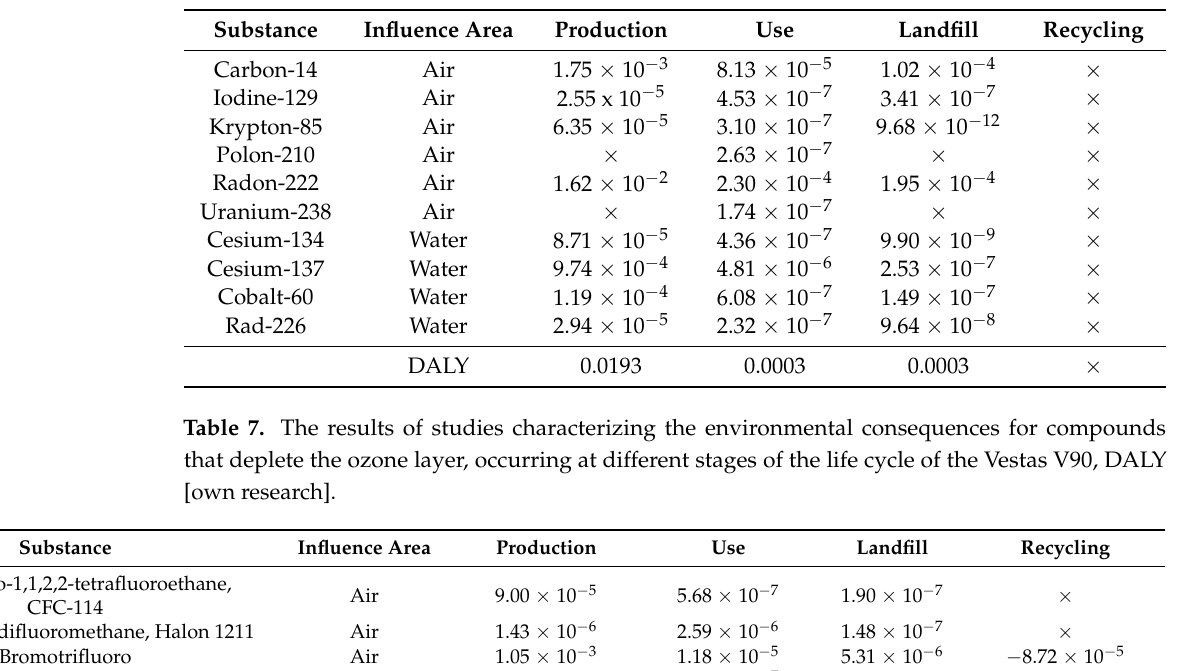
Table 6. The results of studies characterizing the environmental consequences for ionizing radiation occurring in the various stages of the life cycle of the Vestas V90, DALY [own research].